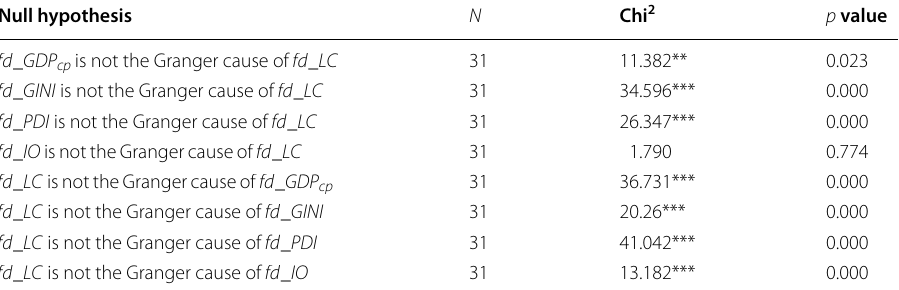
Table 3 Results of conditional Granger causality test (1978–2008)